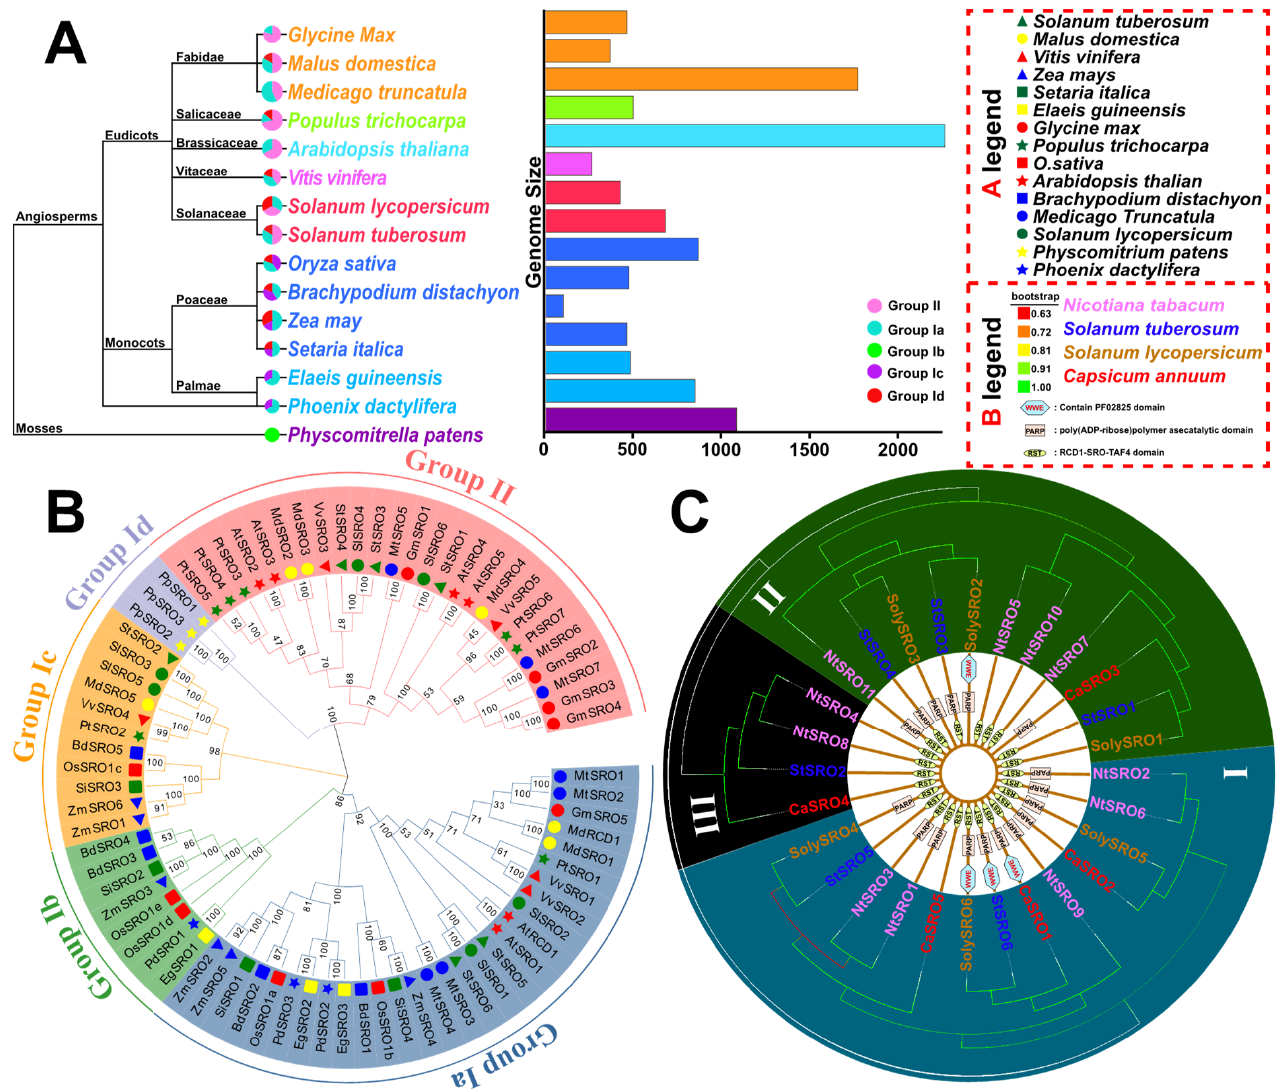
Figure 3. Evolutionary analysis of SRO families in different species. ( A ) The evolutionary relationship and number of SRO families in 15 species, S. tuberosum (6), Malus domestica ( M. domestica , 6), Vitis vinifera ( V. vinifera , 5), Zea mays ( Z. mays, 6), Setaria italic ( S. italic , 4), Elaeis guineensis ( E. guineensis , 3), Glycine max ( G. max , 5), Populus trichocarpa ( P. trichocarpa , 7), O. sativa ( O. sativa , 5), A. thaliana (6), Brachypodium distachyon ( B. distachyon , 5), Medicago Truncatula ( M. truncatula , 7), S. lycopersicum (6), Physcomitrium patens ( P. patens , 3), and Phoenix dactylifera ( P. dactylifera , 3), the color of species represents their taxonomic characteristics, and the size and color of sectors represent the number of SRO families in species and the groups to which they belong. ( B ) Using Neighbor Join (NJ) method in MEGA-X to construct phylogenetic tree, SROs of different species are divided into two groups (Group I and Group II), with different shapes of logos representing different species, as detailed in Supplementary Table S1. ( C ) Phylogenetic tree of the SRO families of Solanaceae, SROs of different Solanaceae species are represented by different font colors, the evolutionary tree shows the conserved domains of corresponding SROs, among which the WWE domain is green, the RST domain is yellow, and the PARP domain is pink, as detailed in Supplementary Table S5.